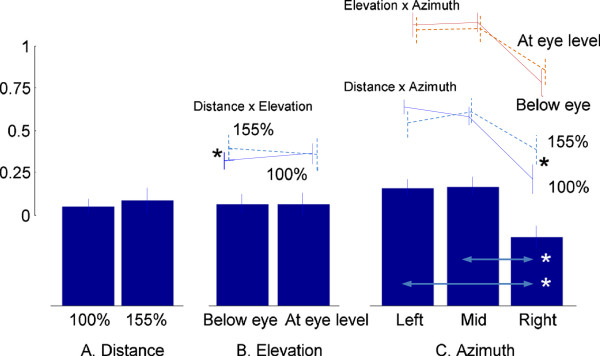
Proportion of torso movement contribution allocated to the MS (torso axial rotation). Values on the y-axis are in a [0,1] scale and unitless (as defined in Equation 6). A value > 0.5 indicates that a larger torso movement contribution is allocated to MS than VS. *denotes a statistically significant difference at p < 0.05. A: Distance, B: Elevation, and C: Azimuth effects.